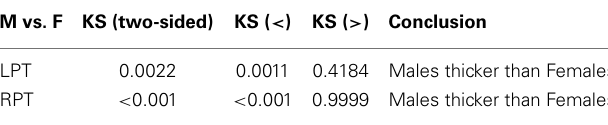
Table 3 | KS test for ECDF comparisons of pooled LCDM distances in gender groups .